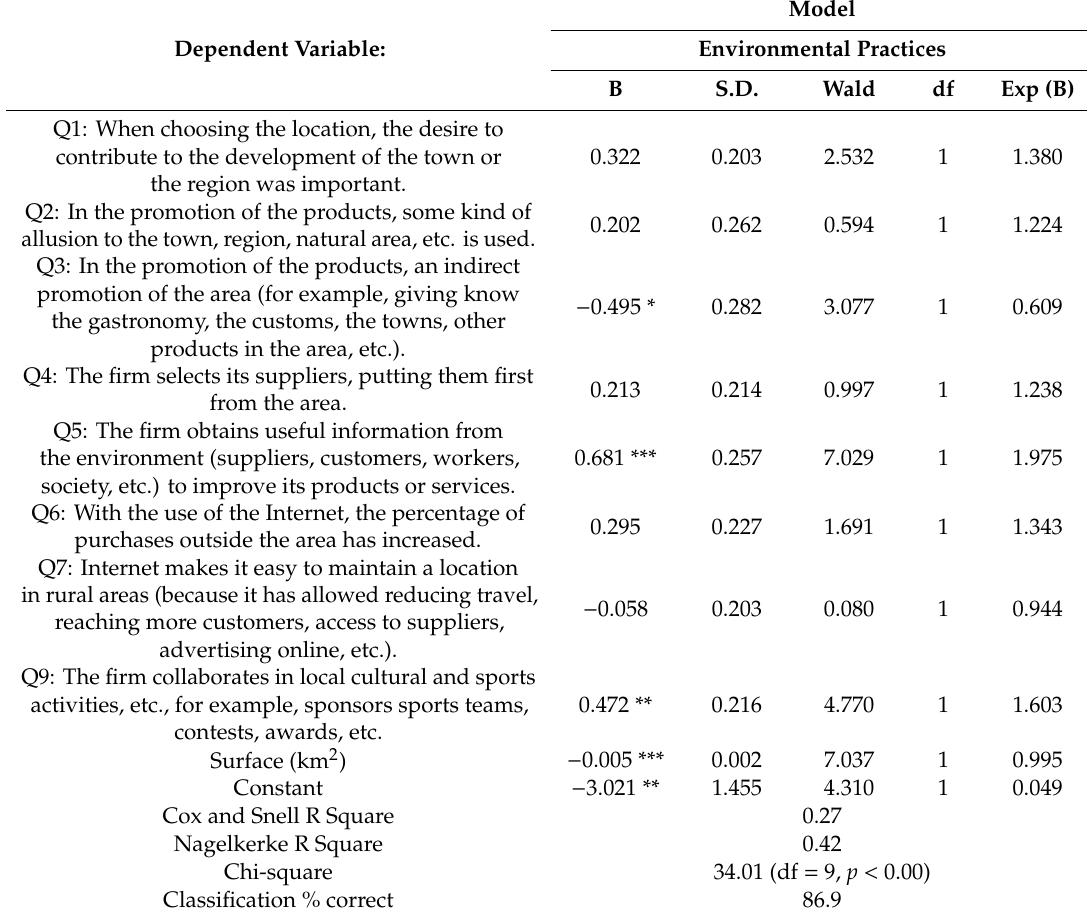
Table 3. Logistic regression of predictors of high environmental